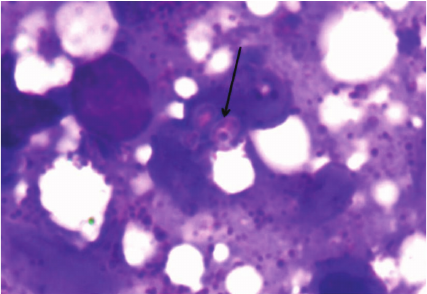
Figure 3: Histopathological examination of the bone marrow show- ing LD bodies within the histiocytic macrophages (black arrow); eosin stain